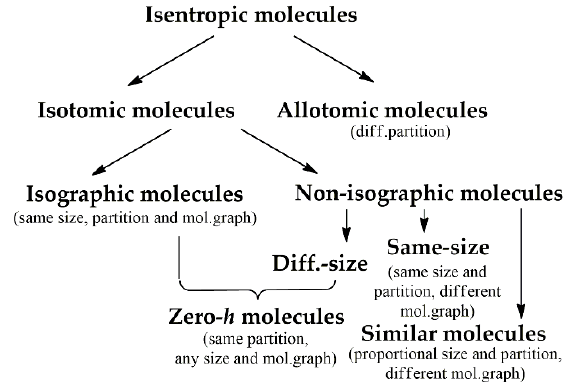
Fig. 5. Classification of isentropic molecules with the distinctive properties of their structures